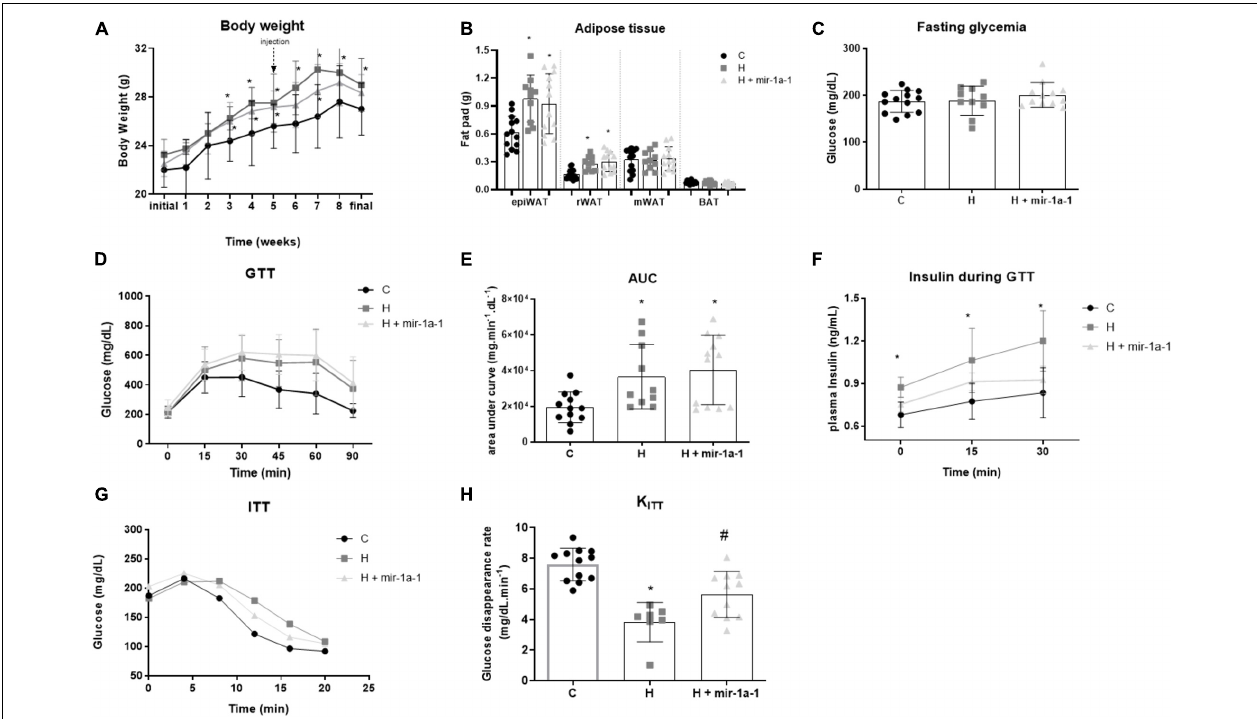
FIGURE 1 | Intramuscular miR-1 precursor (mir-1a-1) replacement therapy improves insulin resistance of obese mice. (A) Time-course of weight gain; (B) white adipose tissue (WAT) mass: epi = epididymal; r = retroperitoneal, m = mesenteric and brown adipose tissue (BAT) mass; (C) Glycemia after a 6h-fasting; (D) Glucose tolerance test (GTT) curve; (E) Area under the curve of GTT; (F) Serum insulin during GTT; (G) Insulin tolerance test (ITT) curve; (H) K ITT calculated from ITT curve. *# p < 0.05 as indicated by one-way ANOVA followed by Tukey’s post-test. (*) vs. control (C), (#) vs. obese (H); n =